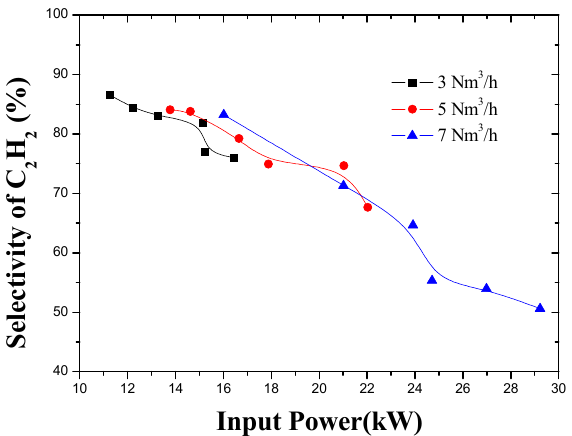
Figure 7. Variation in the selectivity of C 2 H 2 at working gas flow rate of 3 Nm 3 /h, 5 Nm 3 /h, 7 Nm 3 /h (Carrier gas flow rate: 1 Nm 3 /h; feed rate: 17.65 g/min; magnetic flux intensity: 0.077 T).